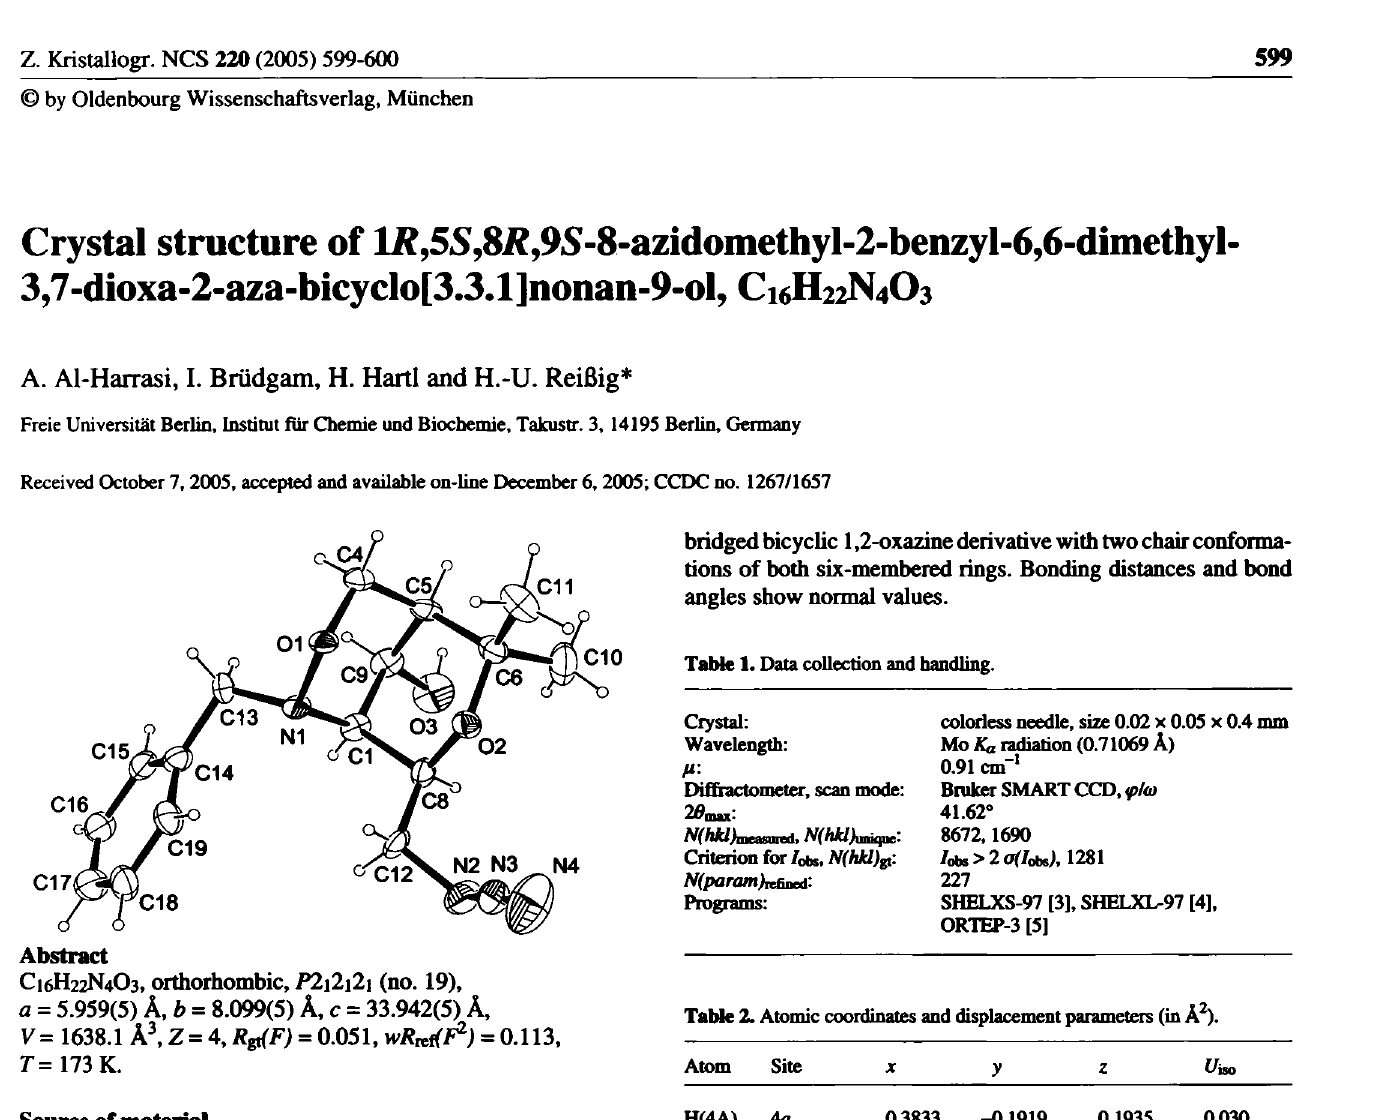
Table 2. Atomic coordinates and displacement parameters (in A 2 ).